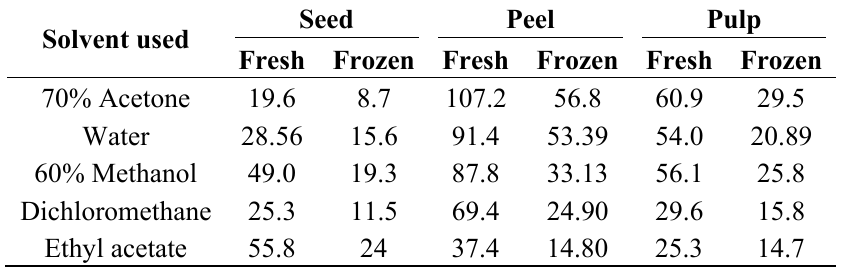
Table 5. ABTS antiradical activity (TEAC μ mol/g) of various parts of fresh and frozen fruit [46].